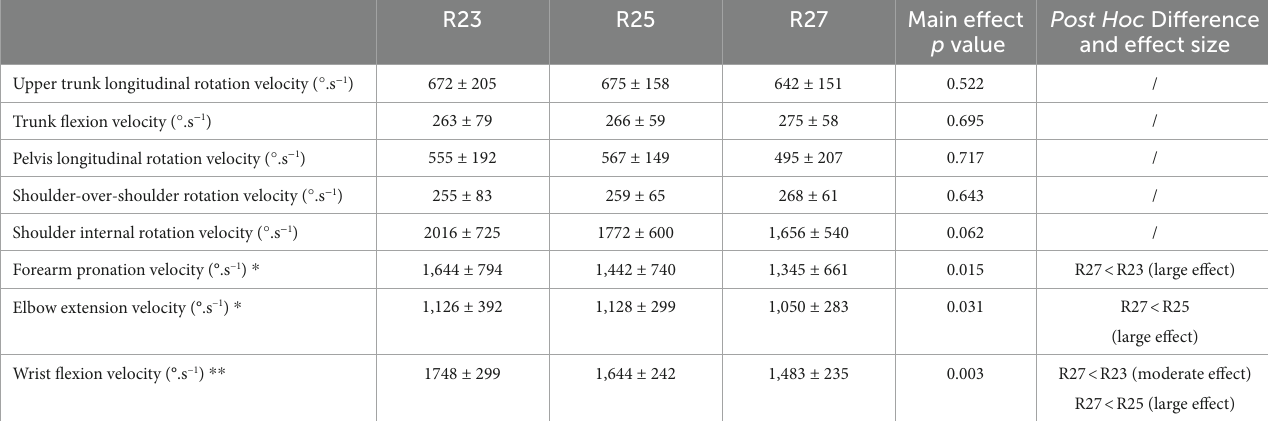
TABLE 4 Maximal upper body kinematics for the different racket conditions (mean ±